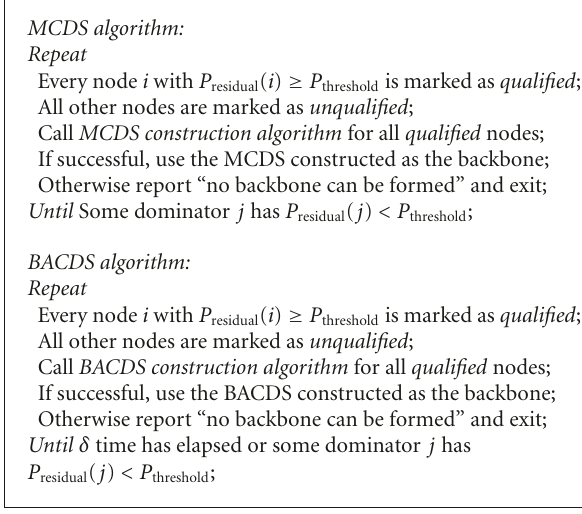
Algorithm 1: Outline of MCDS and BACDS algorithms for